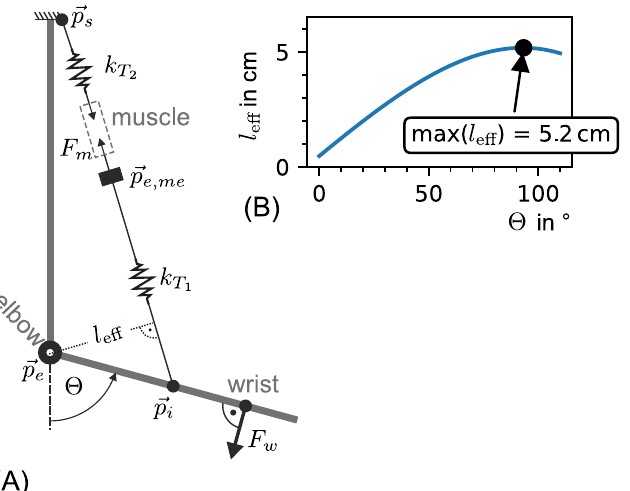
Fig 10. (A) Sketch of the implemented elbow moment arm model with (B) example data of subject 0. (A) Schematic depiction of the applied biomechanical model of muscle and tendon in the elbow joint. k and k are non T 1 T 2 linear spring elements representing the lower and upper biceps brachii tendons. The shoulder and lower arm insertions are also marked ( ~ p and ~ p ). These points were determined based on anatomic landmarks as formulated in Eq (37). The s i elbow joint was abstracted as revolute joint. It was located at ~ p . The effective lever length of subject 0 is shown in (B) e over the elbow joint angle Θ . The maximal effective lever length is marked at ( Θ = 93.3 � , l eff = 5.2cm). The parameter vector ~ r was estimated with a fit on the collected subjects’ data. As a target function for the fit, the myotendinous displacement Δ L ( F ) as a function of the wrist force w mt was used. This is because the wrist forces F were voluntarily adjusted by the subjects during w the experiments and have only a small variance per force interval (see Fig 7). For the myoten- ;~ r Þ from Eq (12) was used. dinous displacement Δ L ( F ), the formulation for D l Rack ð F w mt T T Estimation of the tendon force. In this work, tendon displacement was predicted based on the measured wrist force F and an abstraction of the skeletal geometry as shown in Fig w 10A. The model results in an effective lever l . From this, the tendon force could be calcu- eff lated by